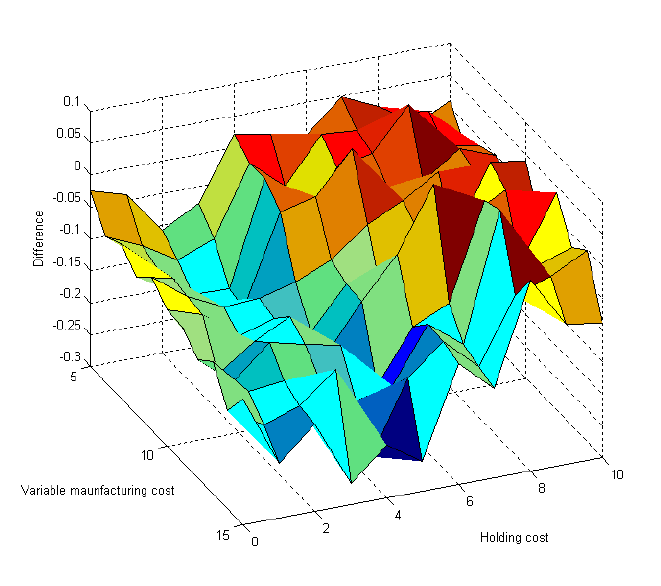
Figure 3. Differences between costs, calculated as explained in section 3 for the approximated system and the simulated cost calculated in the system described in section 2